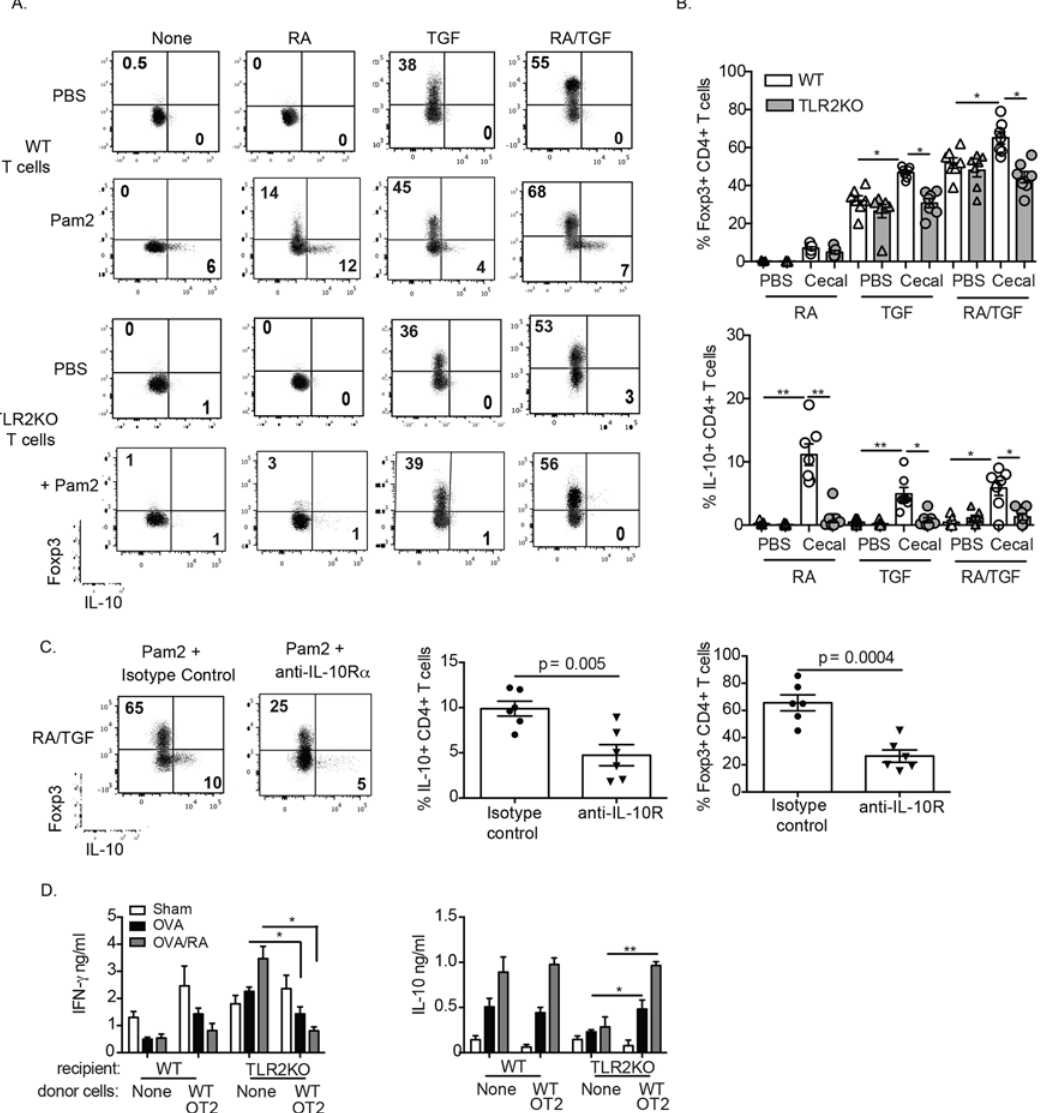
Fig 5. TLR2 and RA act in concert to potentiate iT REG generation via IL-10 production. Foxp3 and IL-10 expression by WT and TLR2KO T cells stimulated with Pam2CysK4 (A) or cecal lysate (B) in the presence or absence RA, TGF- β or RA/TGF- β . Data are representative plots from three independent experiments for (A) and mean and frequency of Foxp3 + IL-10 + and IL-10 + CD4 + T cells from WT (white bars) and TLR2KO (gray bars) treated with cecal lysate (n = 5 – 7 mice) for (B). (C) Frequency of Foxp3 and IL-10 expression in WT T cells cultured with Pam2Cysk4, RA and TGF- β and treated with anti-IL-10R α antibody or isotype control. Data are representative FACS plots from six independent experiments shown in the bar graphs. (D) Cytokine production from re-stimulated in vitro MLN cells of WT and TLR2KO mice fed OVA. Data are the mean ± SEM of two independent experiments with three mice per group. * , p < 0.05, ** , p <